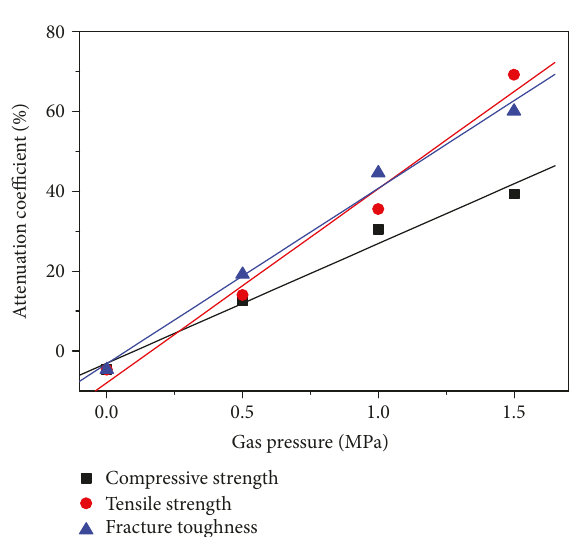
Figure 7: Attenuation coe ffi cient of mechanical properties of gas-containing coal under di ff erent gas